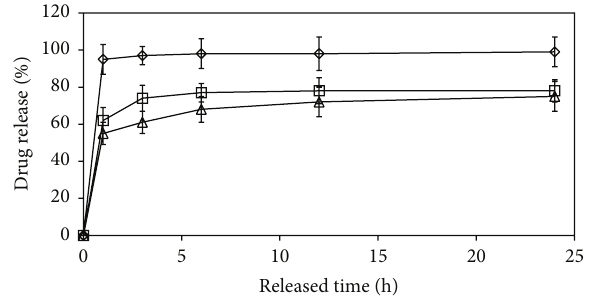
Figure 5: In vitro drug release profiles of drug-loaded gelatin microparticles crosslinked with different glutaraldehyde ratios. ( ⬦ ) non-crosslinked gelatin, ( ◻ ) 12.5 g glutaraldehyde/100 g gelatin, and ( Δ ) 25 g glutaraldehyde/100 g gelatin.